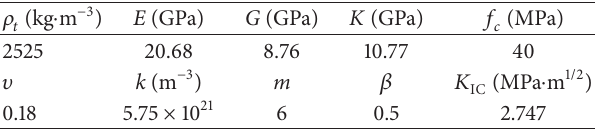
Table 2: Material constants for the TCK model of 40 MPa concrete.